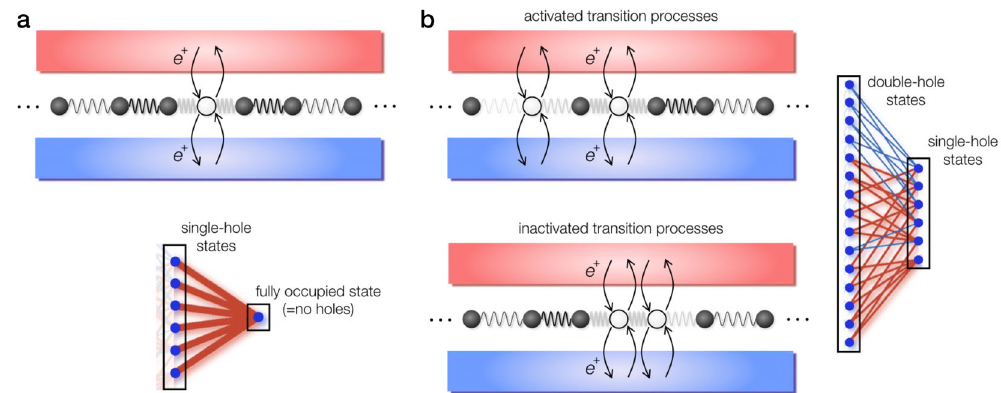
Fig. 5 Transport processes relevant to the highest-power machines. a Transport process between two reservoirs associated with a single-hole excitation. This type of processes lead to the activation of all the transfer edges in the state-transfer networks between the fully occupied state (i.e., the no-hole state) and the single-hole states. The blue and red reservoirs represent the cold and hot ones, respectively. b Transport processes between two reservoirs associated with two-hole excitations, which correspond to activated and inactivated state transitions, respectively. In the latter, the inactivation of the transitions originates from the energy mismatch in two-hole states due to the inevitable hole – hole interaction between two holes. Here, the white and black nodes represent the empty and occupied electron levels, respectively. The wavy lines indicate the interaction and the arrows represent the exchanges of electrons with reservoirs. Only a part of the transfer edges between single-hole states and double-hole states can be activated, where red (blue) edges correspond to activated (inactivated) edges. The fraction of the activated edges in the highest-power machines can asymptotically approach to the unity in the thermodynamic limit (see the fi gures in “ Methods ”